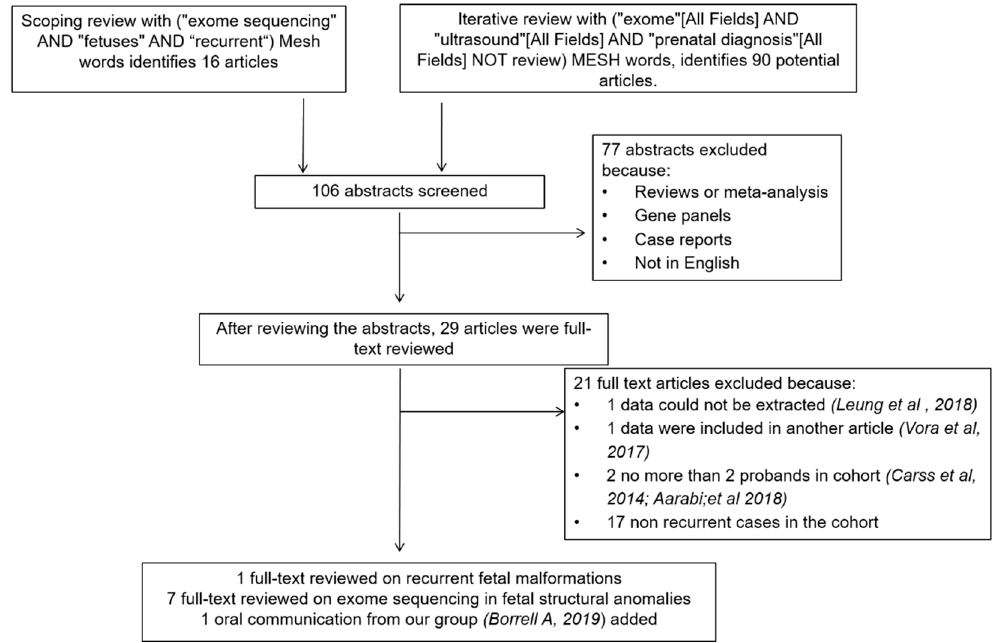
Figure 1. Flowchart summarizing inclusion in this systematic review of studies reporting on diagnostic yield of exome sequencing in fetuses with recurrent structural anomalies and a negative chromosomal microarray analysis or karyotyping, and no family history.